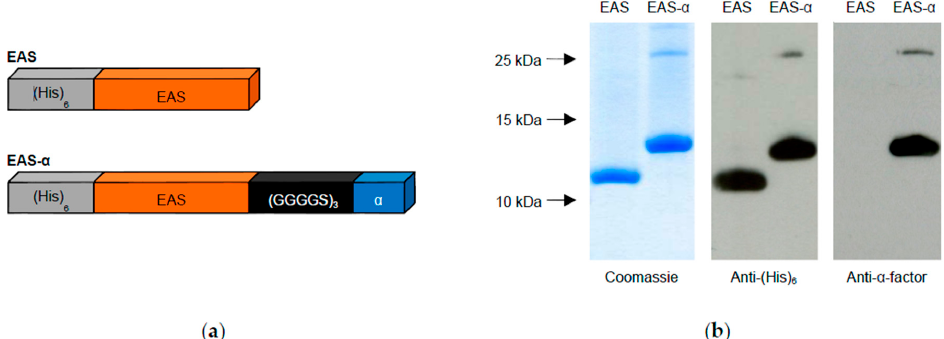
Figure 1. Hydrophobin design and purification. ( a ) Schematic illustration of the hydrophobins EAS and EAS- α . The EAS domain (orange) of the mature EAS hydrophobin from Neurospora crassa was fused to the (His) 6 -tag (gray) at its N-terminus for protein purification. In addition, EAS- α includes the sequence of the yeast α -factor (blue) fused to the C-terminus of the EAS domain via a flexible (GGGGS) 3 linker (black); ( b ) Protein purification by Ni 2+ affinity chromatography. Recombinant hydrophobins were purified as described in Materials and Methods, a sample was separated by Tricine-SDS-PAGE and visualized by colloidal Coomassie staining or immunologically detected by the indicated antibodies. Molecular weight is indicated at the left.